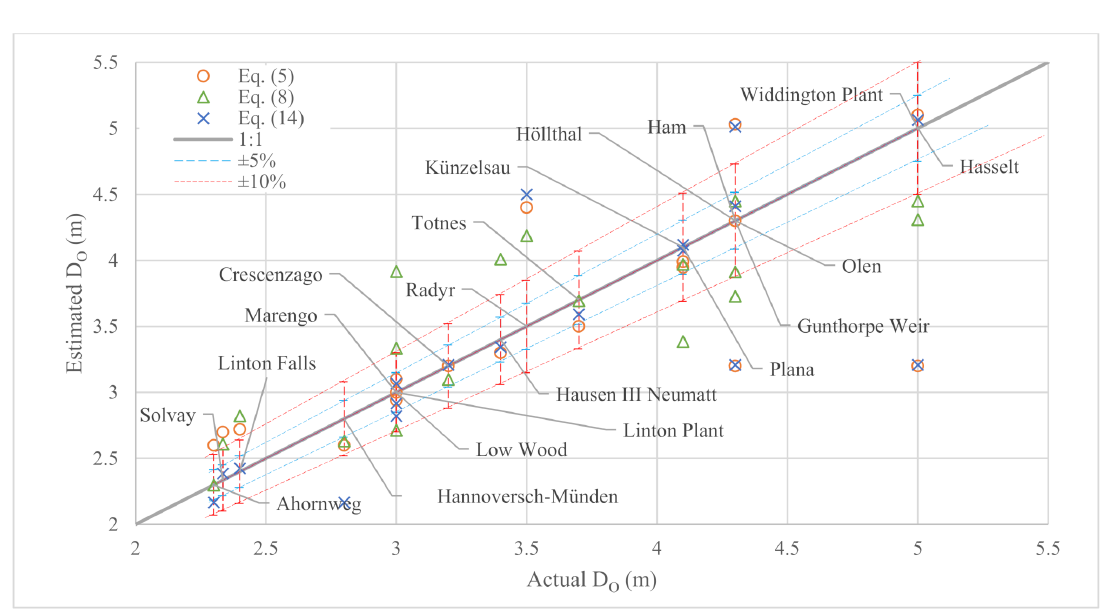
Figure 9. Graphical comparison of Equations (5), (8) and (14) estimations vs. actual overall diameter of ASG